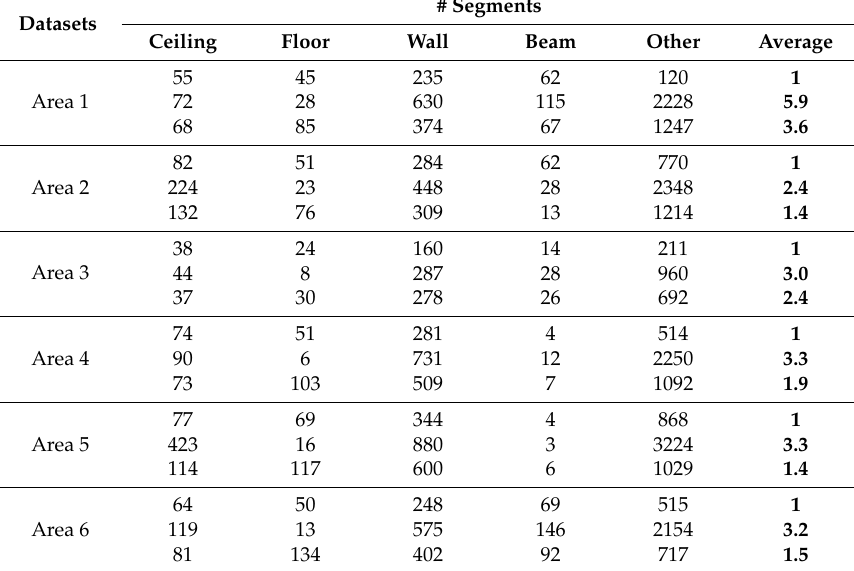
Table 5. Object class statistics of the segments produced by the point- and mesh-based segmentation procedures. The top, middle and bottom row depict the number of segments that was generated per object class for respectively the ground truth, the point-based and the mesh-based approach. The right column shows the average number of segments created per object compared to the ground